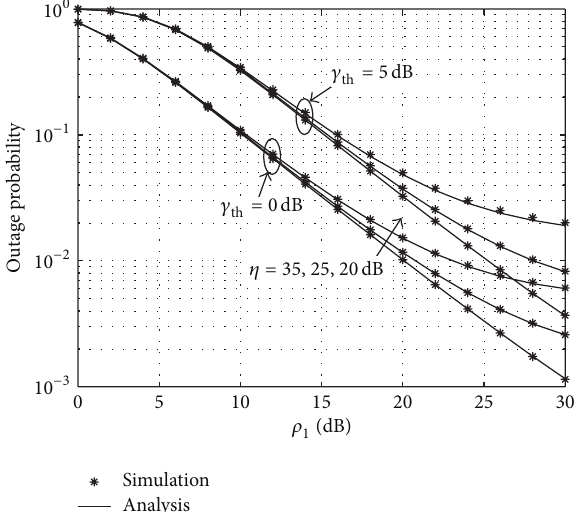
Figure 5: Outage probability of the DF relaying system without MRT versus SNR.